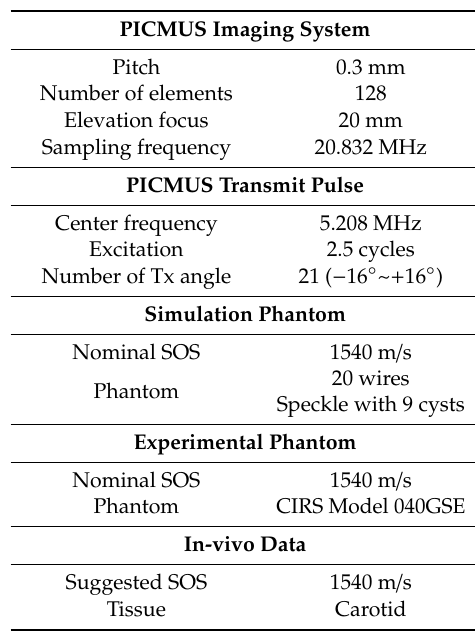
Table 1. The parameter of PICMUS dataset.